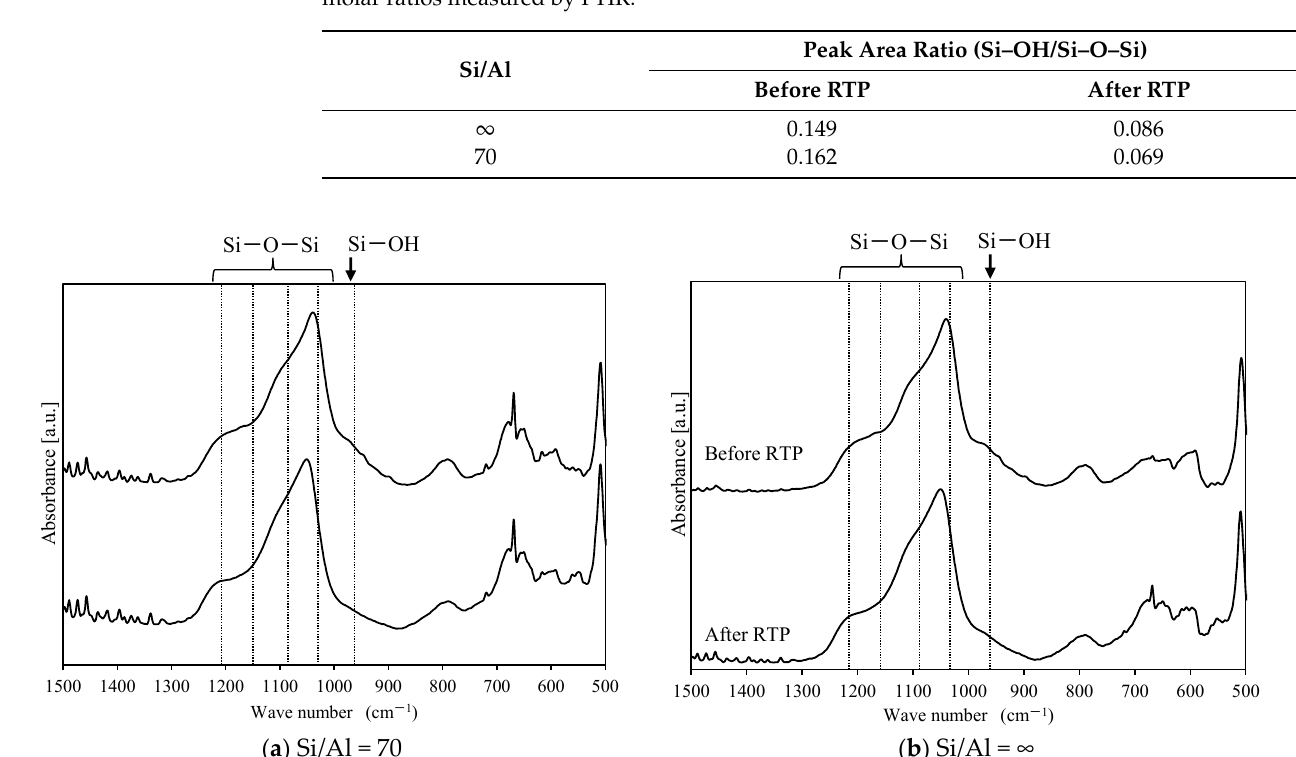
Figure 14. FTIR spectra (500 to 1500 cm − 1 ) of ZSM-58 zeolite membranes with Si/Al ratios of 70 ( a ) and ∞ ( b ) prepared using the ATR method before and after RTP treatment.